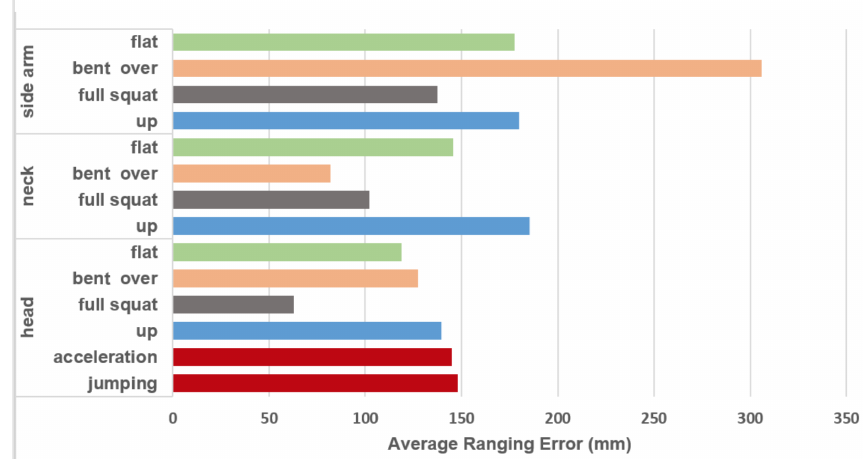
Figure 7. Impact of different postures and activities on ranging accuracy while estimating the distance to eight anchors. Table 3. Impact of different postures and activities on packet loss while ranging with eight